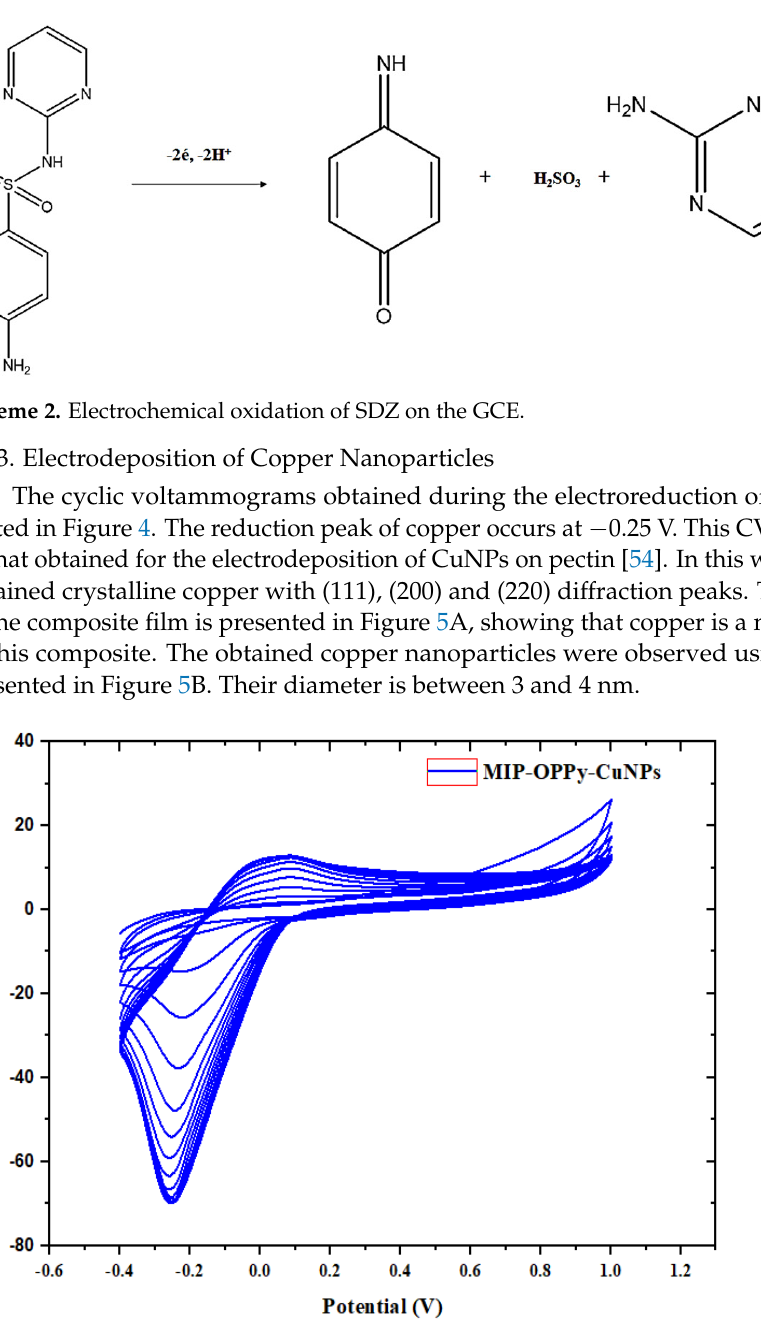
Figure 3. Overoxidation of the imprinted PPy for the extraction of SDZ in 0.1 mol L − 1 NaOH solution.